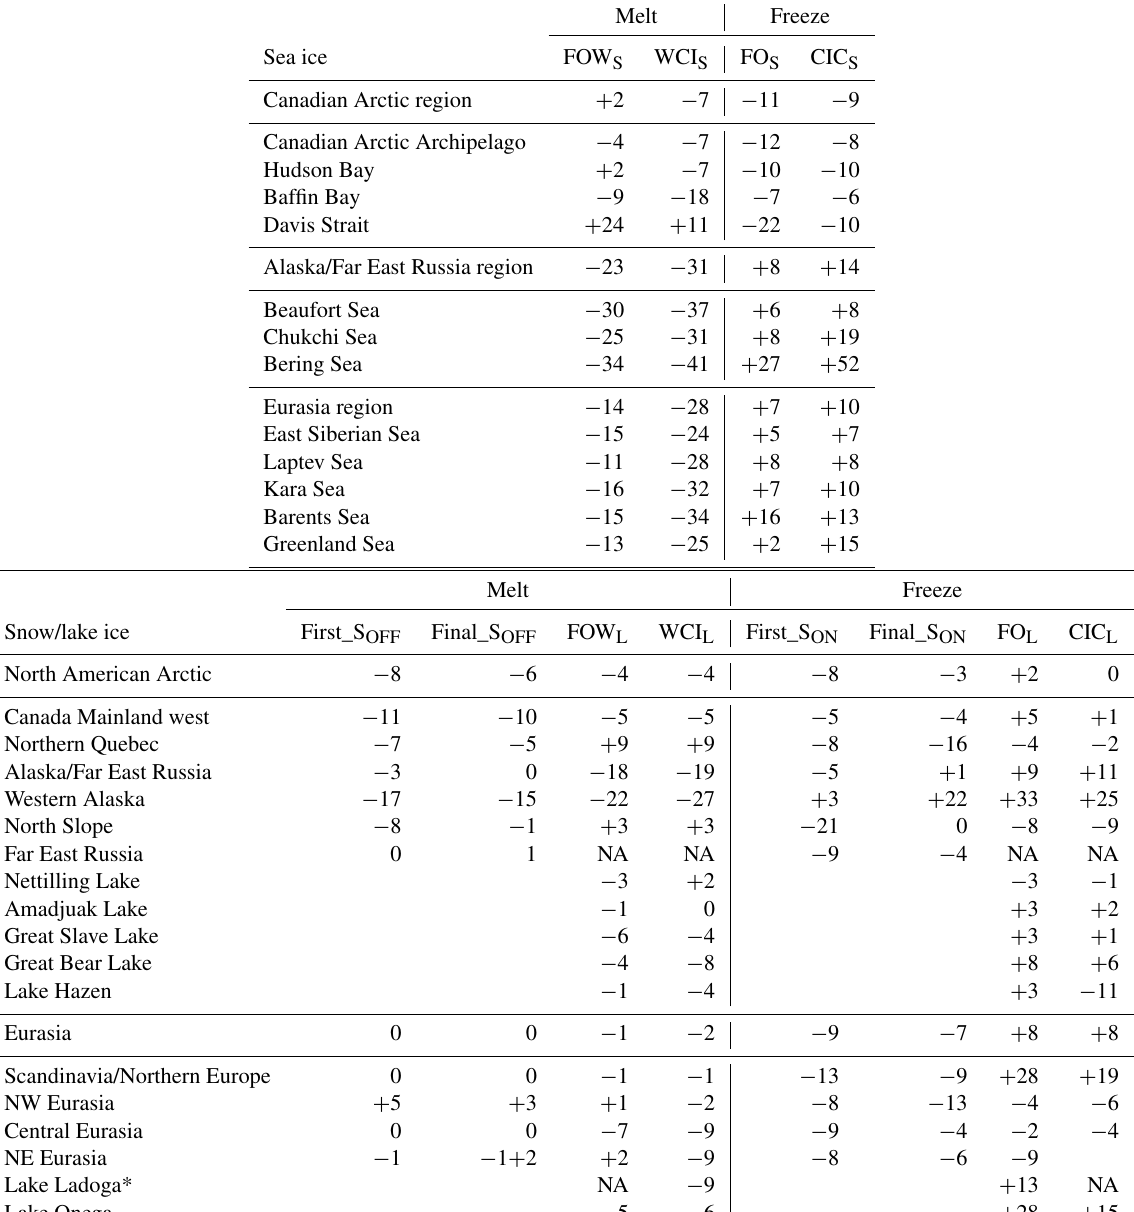
Table 3. Regional analysis (see Fig. 1) of the median trend strength (days/16 years) and direction ( − earlier, + later) for all of the phenology parameters: first open water (FOW, subscript S denotes sea ice, L denotes lake ice), water clear of ice (WCI, subscript S denotes sea ice, L denotes lake ice), freeze onset (FO, subscript S denotes sea ice, L denotes lake ice), complete ice cover (CIC, subscript S denotes sea ice,